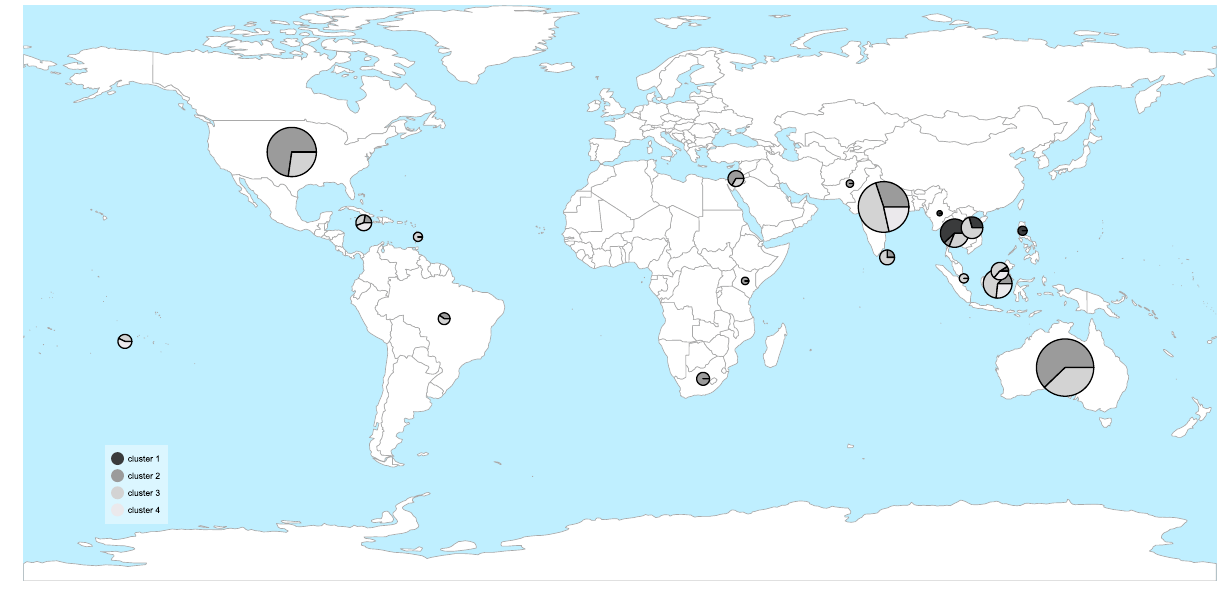
Figure 2. Genetic structure across geography of the 208 M. indica accessions. Cluster numbers (K = 4) were determined using a hierarchical cluster analysis (Fig. 1). The size of each pie chart reflects the number of accessions imported from each country. The world map was created in “rworldmap” v1.3–6 R-package (https:// cran.r- proje ct. org/ web/ packa ges/ rworl dmap/).